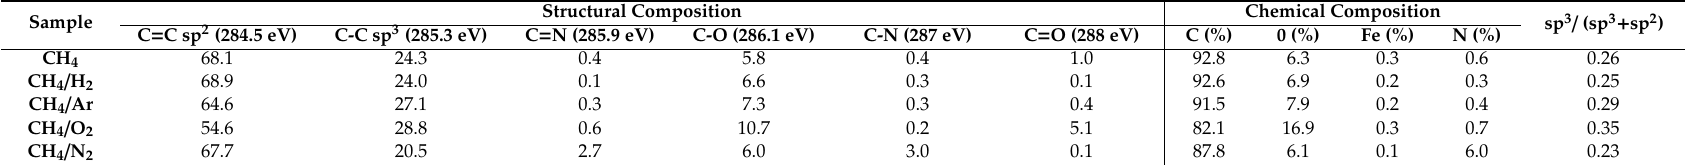
Table 3. Analysis of chemical and phase composition of produced carbon